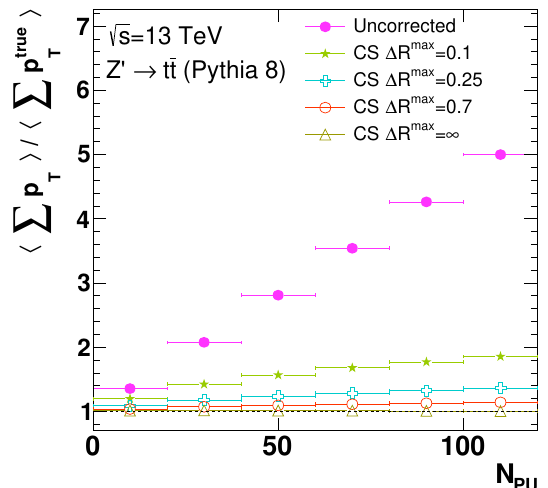
Figure 11. Ratio between the h P p T i for various (cid:1) R max parameters used in the Event-wide CS and h P p true i as a function of N PU T